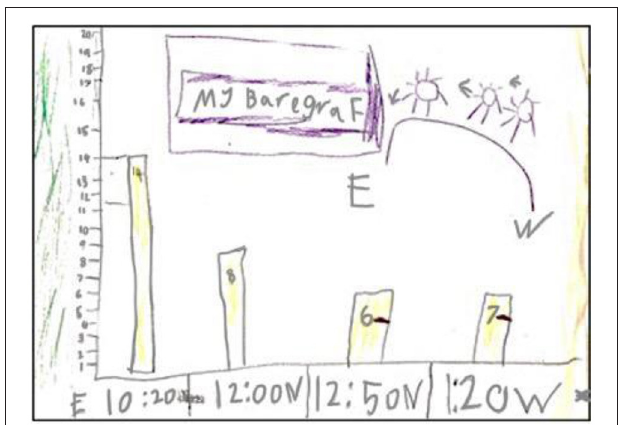
FIGURE 11 | Anthony’s